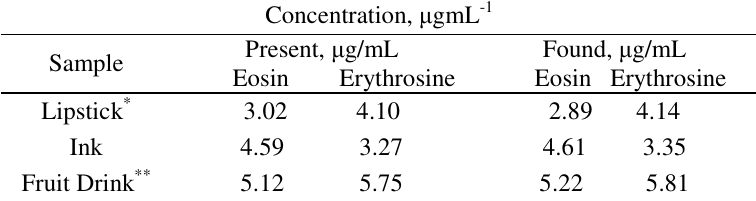
Table 2. Determination of eosin and erythrosine in different samples by HPSAM Concentration, µ gmL -1 Present, µ Sample